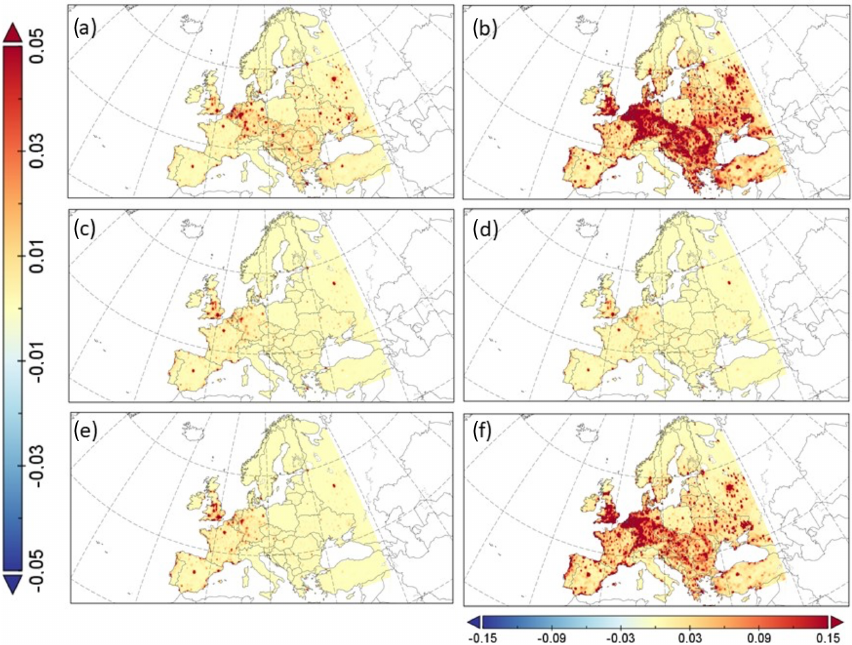
Figure 11. Differences in future premature mortality for the future scenario considering the population dynamics for 2050 (FUT-P2050). Endpoints considered are (a) CEV, (b) IHD, (c) COPD, (d) LC, (e) LRI and (f) all endpoints. All values are in PDkm − 2 .